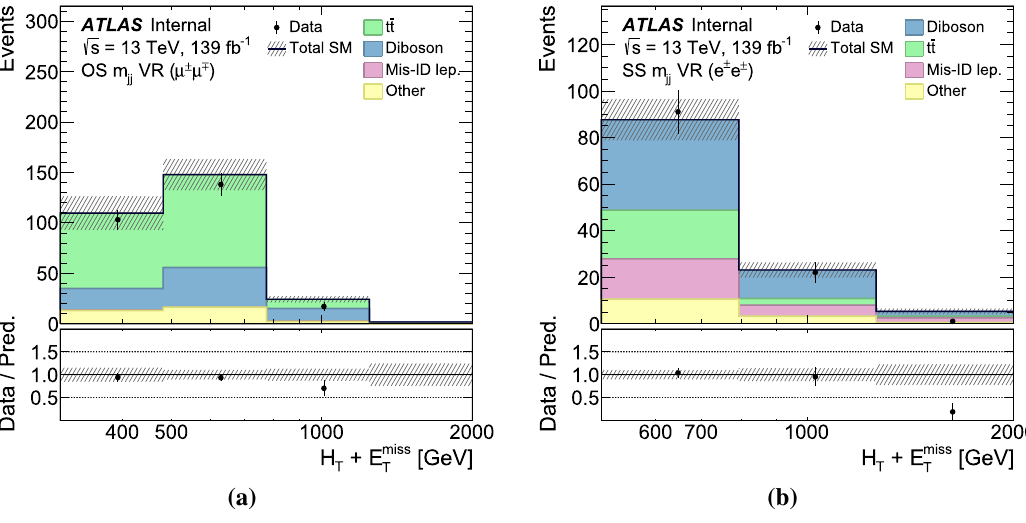
Fig. 2 Post-fit distributions of the H T + E miss ous sources taken into account. Errors on data are statistical only. The variable for data and T lower panel shows the ratio of the observed data to the estimated SM SM background predictions in two validation regions, namely a in the OS μμ m jj VR and b in the SS ee m jj VR. The hatched bands include all systematic uncertainties post-fit with the correlations between vari-